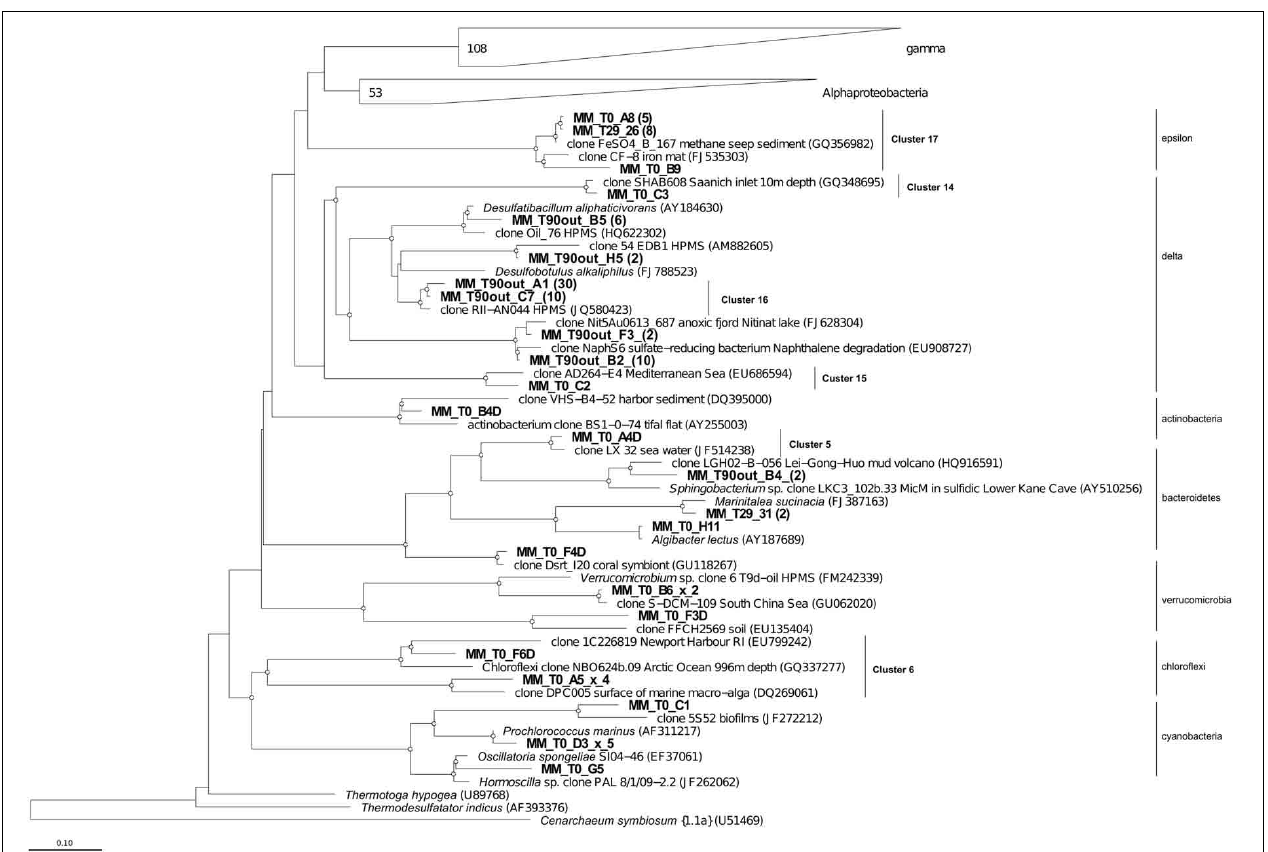
FIGURE 6 | Phylogenetic affiliation of the Eubacteria clones retrieved in Messina harbor native sediments and during mesocosm experiment. Neighbor-joining analysis using 1000 bootstrap replicates was used to infer tree topology. The scale bar represents 10% of sequence divergence.